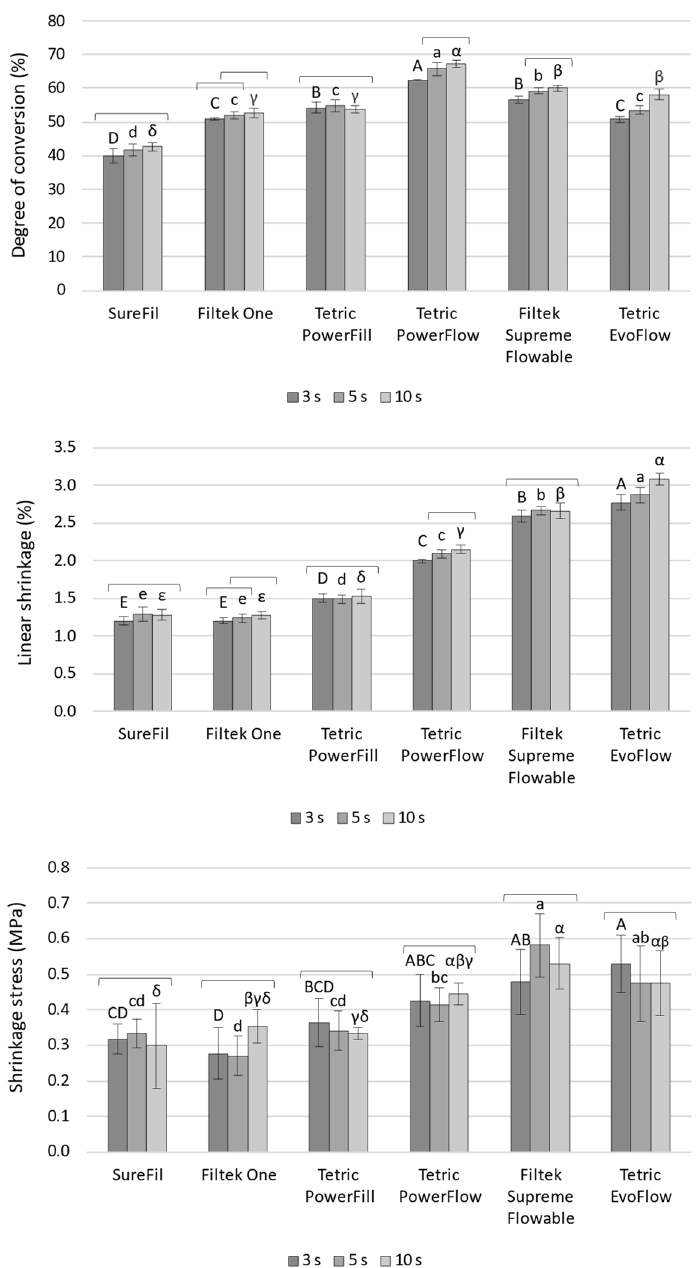
Figure 1. Degree of conversion, linear shrinkage, and shrinkage stress measured at the end of the 5 min observation period (mean values ± 1 SD). Statistically similar values among curing protocols are connected with square brackets. Statistically similar values among materials are denoted by same uppercase, lowercase, and Greek letters for the 3, 5, and 10 s curing protocols, respectively.